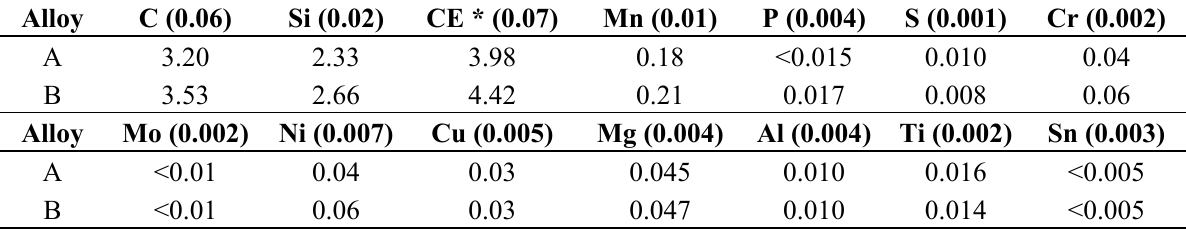
Table 1. Chemical composition of the prepared cast irons